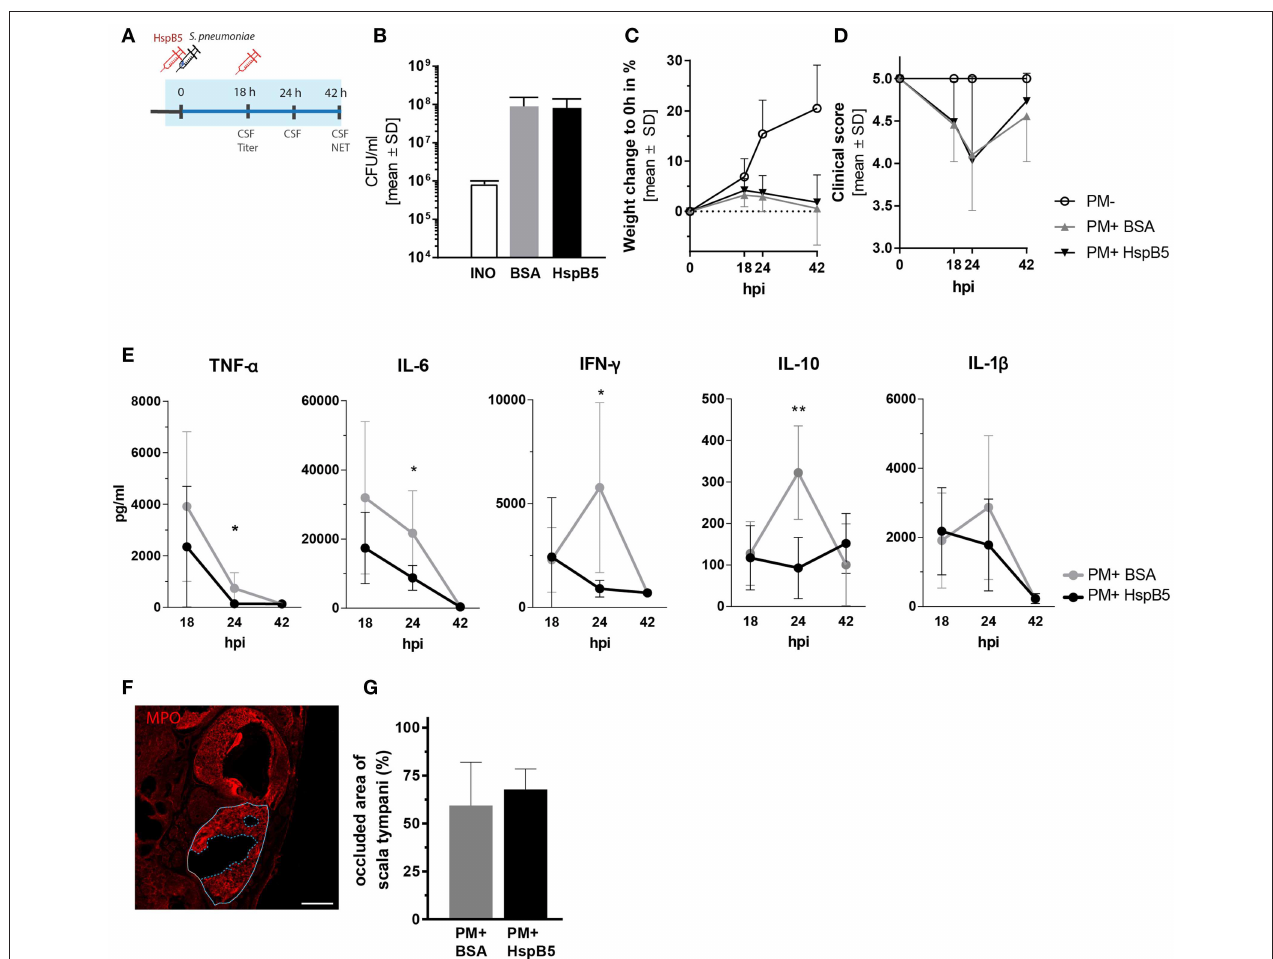
FIGURE 3 | Intracisternal administration of HspB5 and effects during the acute phase of pneumococcal meningitis. (A) Schematic representation of the experimental setup to study the acute phase outcomes. Intracisternal delivery of HspB5 (red syringe) is performed immediately prior to the infection and at 18hpi. Antibiotic treatment is initiated at 18 hpi and administered i.p. The acute phase (0–42h) is indicated in blue. (B) Bacterial titer at 18 hpi indicates colony forming units in 1ml of CSF (C) Relative weight change during acute infection showed a slight increase within the first 18 hpi and weight loss with the onset of clinical symptoms and antibiotic treatment. (D) Clinical scores deteriorated during the first 24h after infection before sick animals recovered. (E) Quantification of inflammatory cytokines in the CSF at 18hpi, 24hpi, and 42hpi of untreated (gray, n = 9 animal) and treated animals (black, n = 10 animals) Statistical differences were assessed using unpaired t -test with Welch correction * p < 0.05; ** p < 0.01. (F) Representative immunofluorescence of NET occlusion (basal turn) in infected animals with delineated areas of the scala tympani (white line) and NET occlusion (blue dashed line). Scale bar = 200 µ m. (G) The ratio between the NET-occupied area and the area of scala tympani 42h post infection, is plotted for untreated (gray, n = 7 animals) and HspB5-treated (black, n = 4